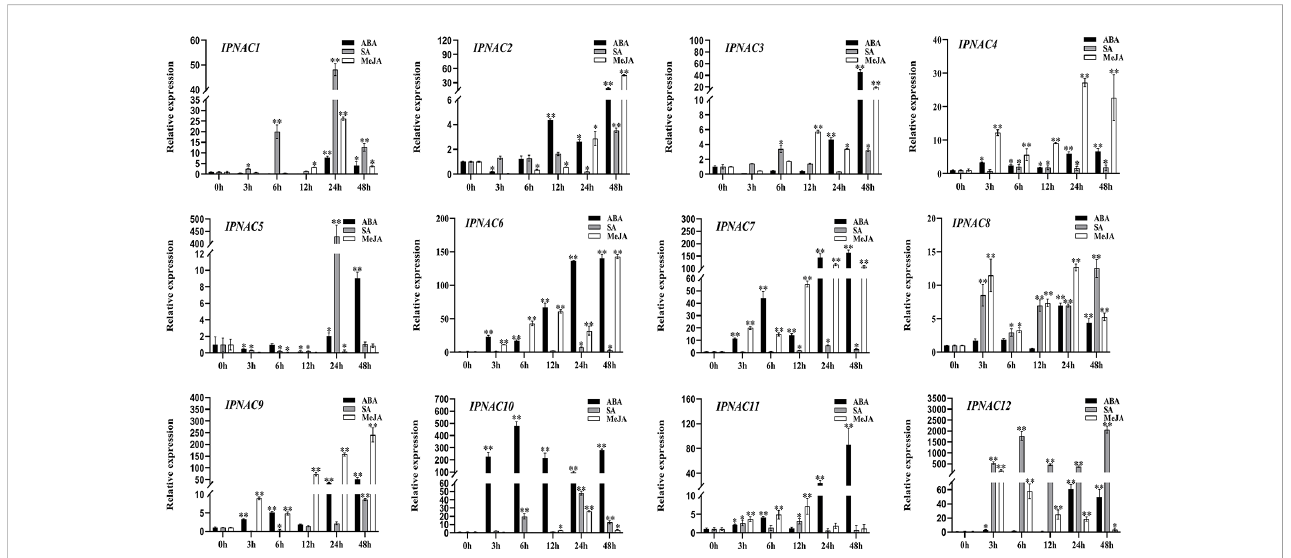
FIGURE 6 The expression level of IpNAC genes in the plant hormone treatment. The roots were soaked in 0.1 mM abscisic acid (ABA), 2 mM salicylic acid (SA) solution, or 2 mM jasmonic acid (JA) solution, and the roots were collected at different time points. Non-stressed plants (0 h) were used as a control, and each experiment was conducted with three biological replicates and three technical replicates. The mean values and standard deviation (SD) were obtained from the experiment. The p-values were evaluated using Student ’ s t -test. Asterisks indicate the level of signi fi cance, ** p < 0.01 and * 0.01 < p < 0.05 . Transcript levels at 0 h were set as